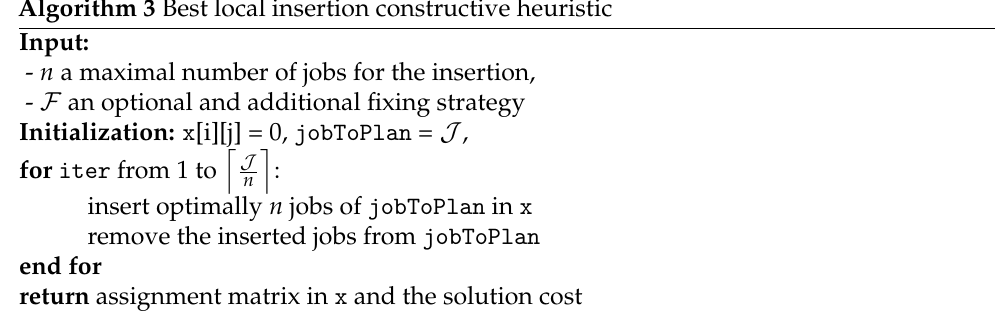
Algorithm 3 Best local insertion constructive heuristic